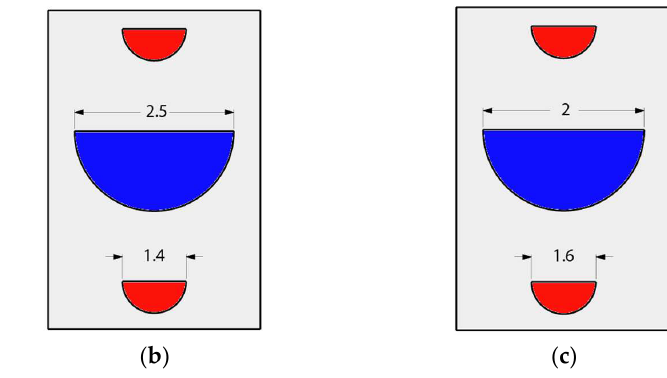
Figure 22. PCHE block optimization: ( a ) case 1; ( b ) case 2; ( c ) case 3 (units in mm).